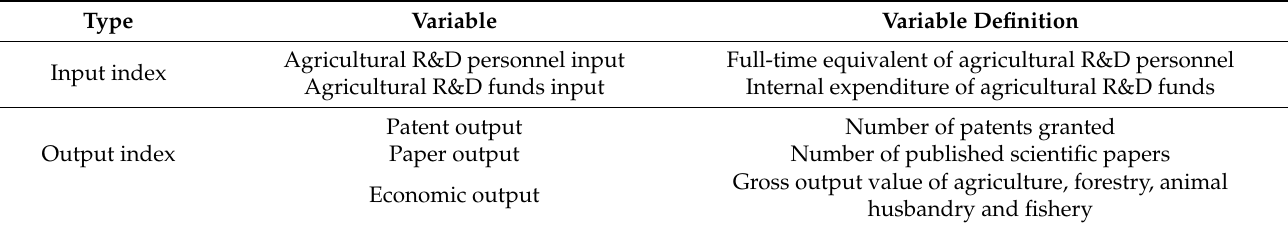
Table 1. Input–output indicators of the DEA model.